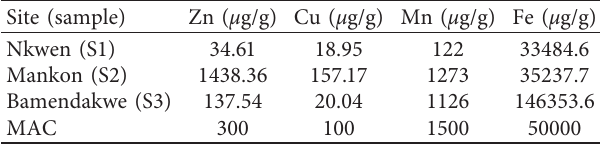
Table 3: Trace element content in soil. Site (sample)